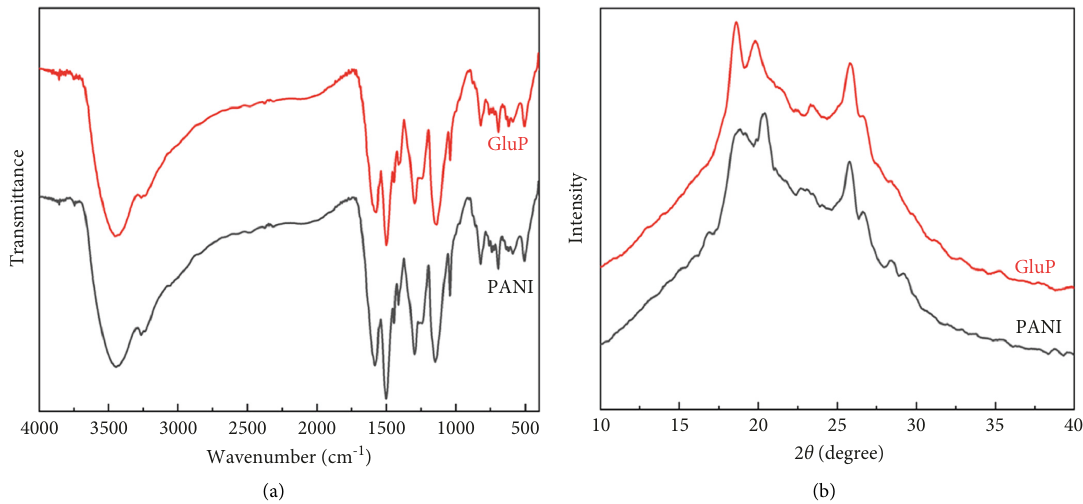
Figure 3: FT-IR spectra (a) and XRD patterns (b) of PANI and GluP,